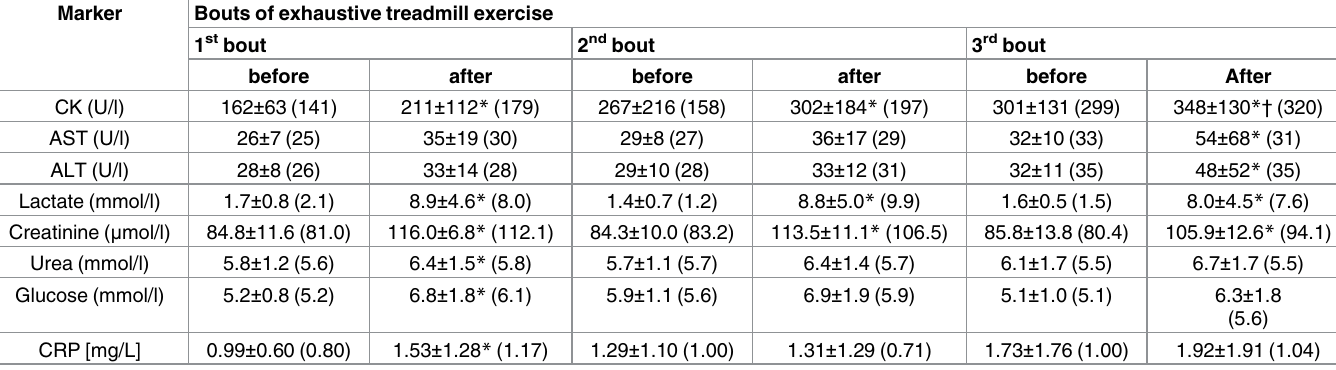
Table 3. Selected markersof muscle damage and metabolic response to exercisebefore and after each of three bouts of exhaustive treadmill exercise. Marker